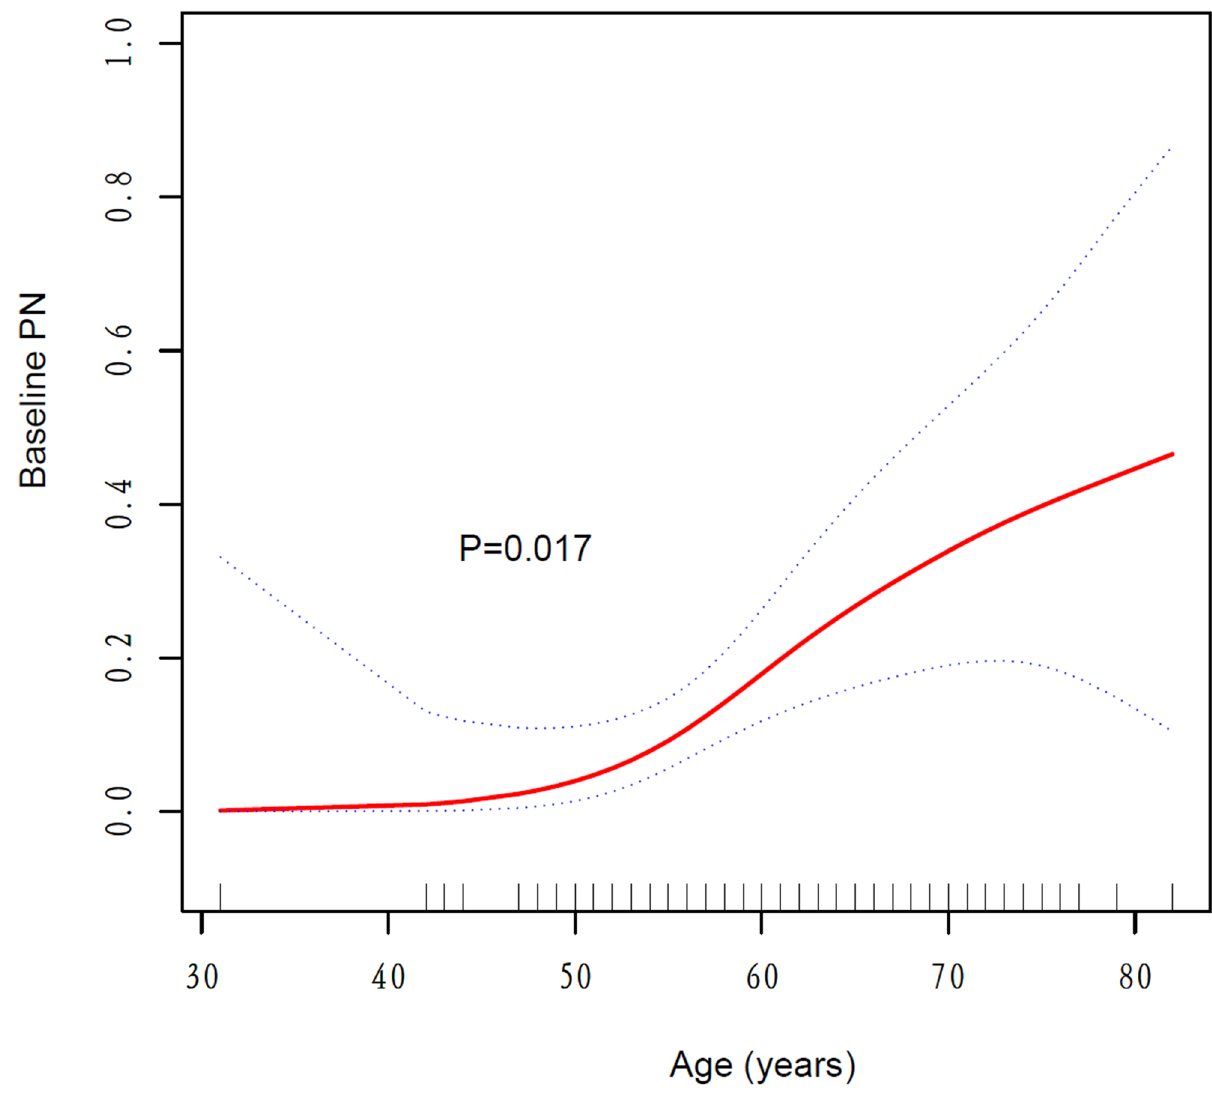
Figure 2. Spline smoothing curve for the cross-sectional correlation between age and baseline peripheral neuropathy ( p = 0.017, created by Empower Stats and R software, www. empow ersta ts. com; http:// www.R- proje ct). Generalize additive models was used in the analysis, the red line represented the fitted relationship between age and baseline PN, and the blue lines referred the 95% CI. The model was adjusted for: gender, immunoglobin type, light chain type, DS stage, creatinine, β2 microglobulin; lactate dehydrogenase. PN peripheral